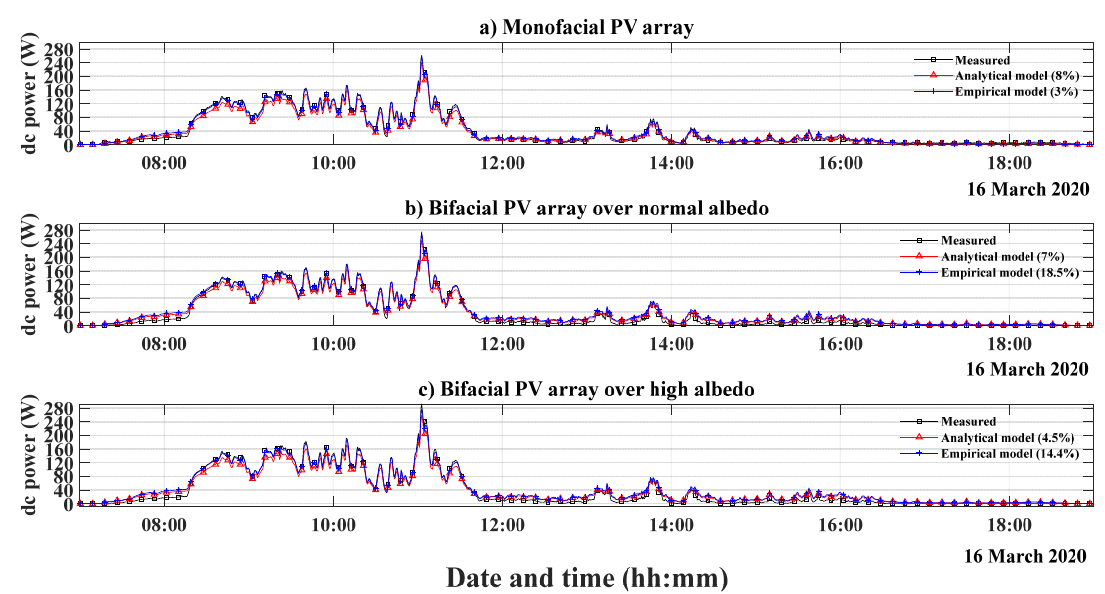
Figure 8. Comparison between the measured and simulated power output of the PV arrays under an overcast sky. ( a ) Measured and simulated DC power of the monofacial PV array. ( b ) Measured and simulated DC power of the bifacial PV array with normal albedo. ( c ) Measured and simulated DC power of the bifacial PV array under high albedo.